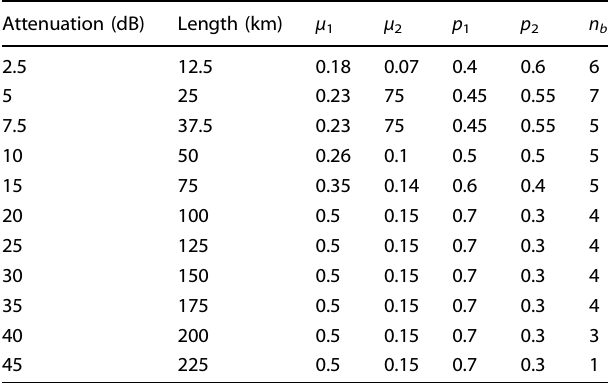
Table 1. Measurement parameters for the QKD transmission.